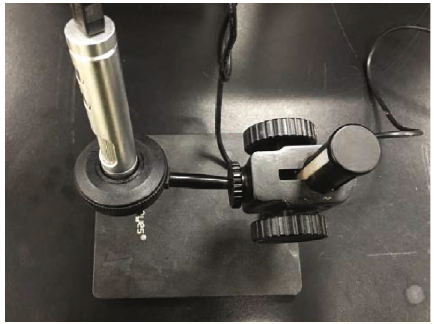
Figure 4: Cryo-structure observation system for frozen soil surrounding a